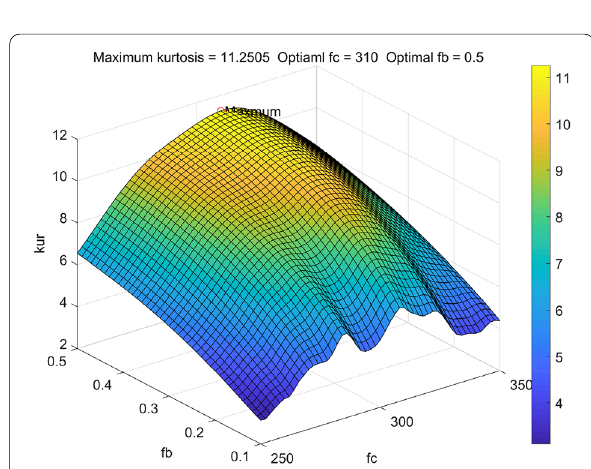
Figure 10 The optimal central frequency and damping ratio obtained by